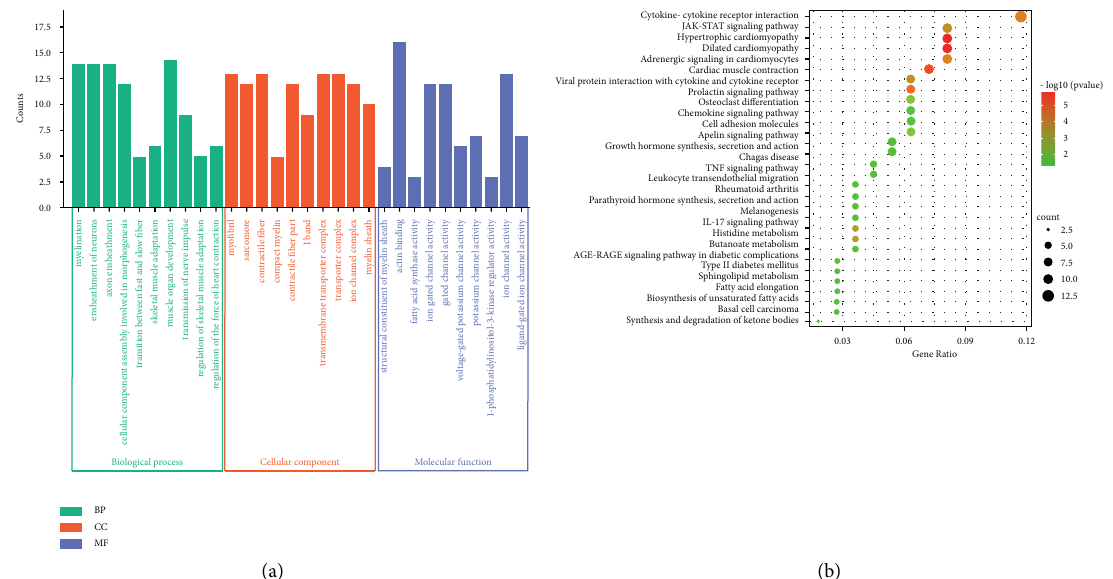
Figure 3: Gene Ontology (GO) and Kyoto Encyclopedia of Genes and Genomes (KEGG) pathway analysis of differentially expressed genes in the three groups. (a) Top 30 GO terms related to differentially expressed mRNAs. (b) Top 30 KEGG pathways related to differentially expressed